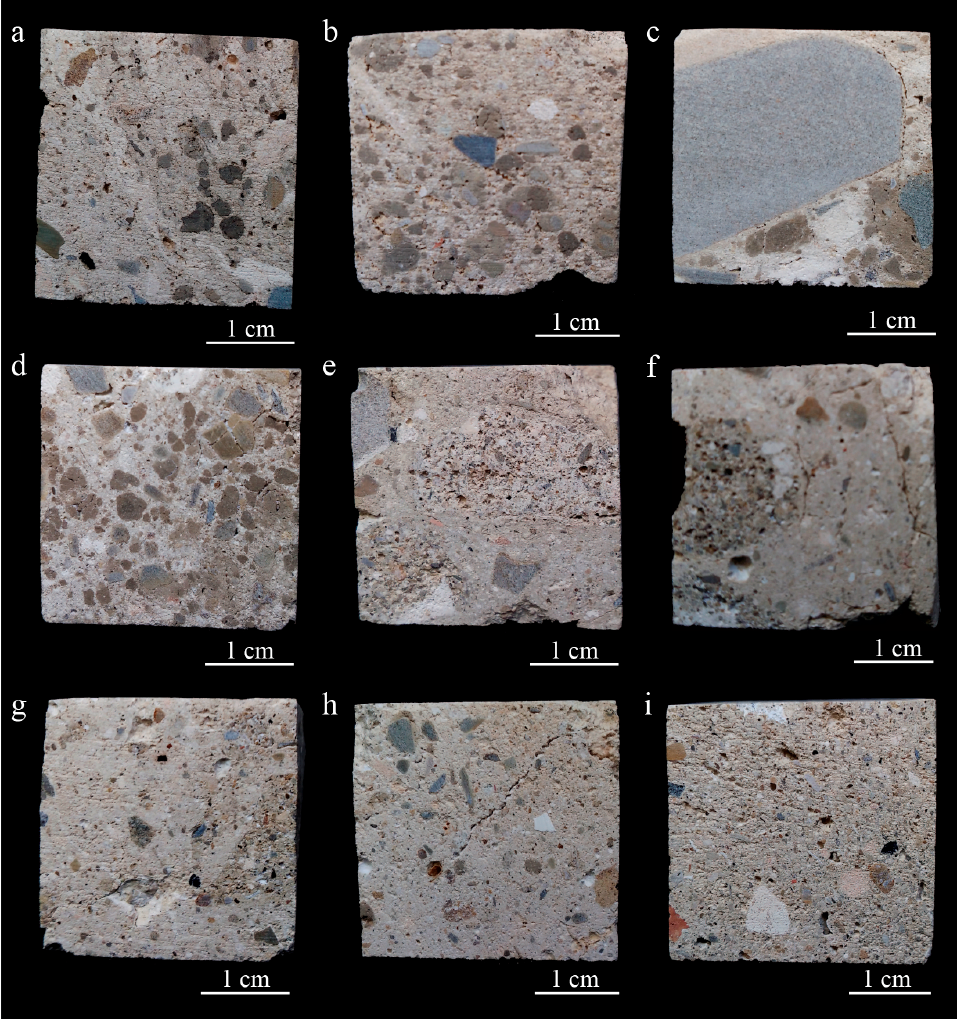
Figure 3. Images of archaeological mortar hand samples showing the heterogeneous texture. ( a ) Sample CI-T-8; ( b ) sample CI-T-10; ( c ) sample CI-T-9, mortar with a big size sandstone aggregate showing porosity at the grain edge; ( d ) sample CI-T-9, mortar with abundant presence of rock fragments; ( e ) sample CI-T-11, ( f ) Sample CI-T-12 and ( g ) sample CI-TE-9, mortars with reused mortar fragments; ( h ) sample CI-TE-8, cracked mortar; and ( i ) sample CI-M-3, showing the most homogeneous texture.